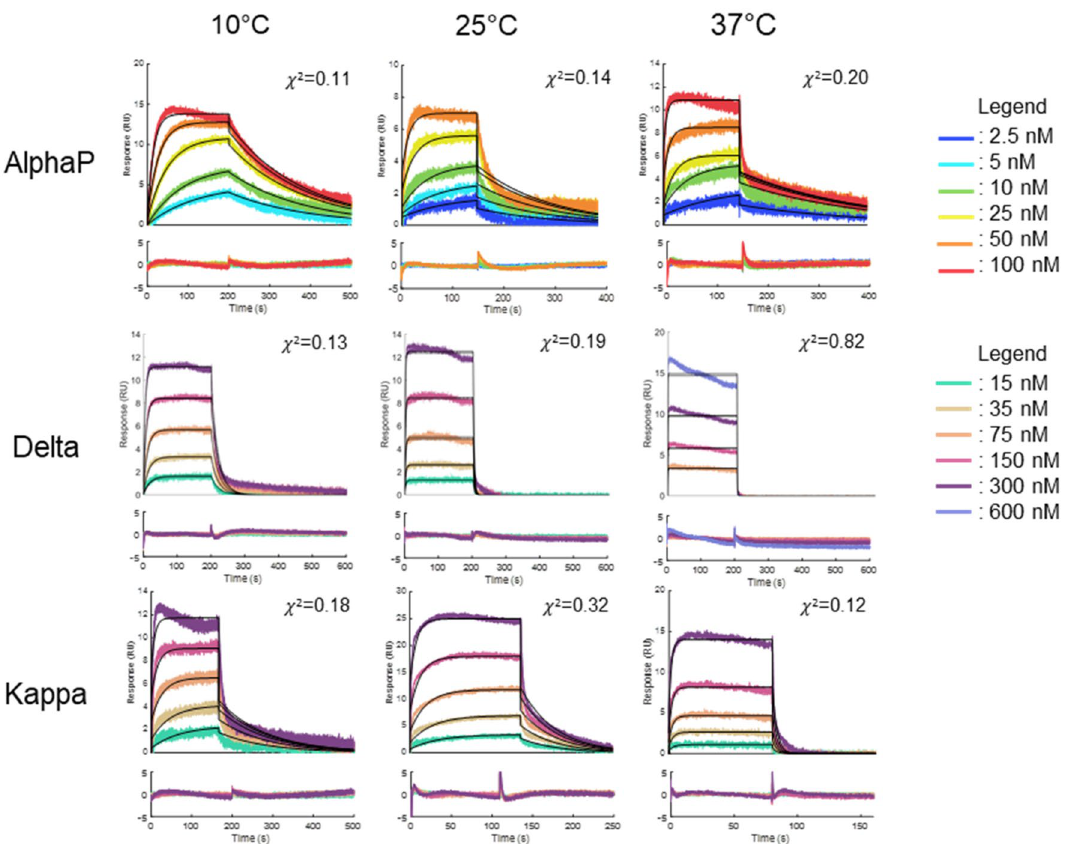
Figure 3. SPR sensorgrams recorded for the RBD variants with the L452R mutation interacting with tethered ACE2 at different temperatures. The sensorgrams corresponding to variant injections at 10, 25 and 37 °C were globally fitted with a 1:1 Langmuir binding model (black solid lines). Residual plots are included underneath each sensorgram series.